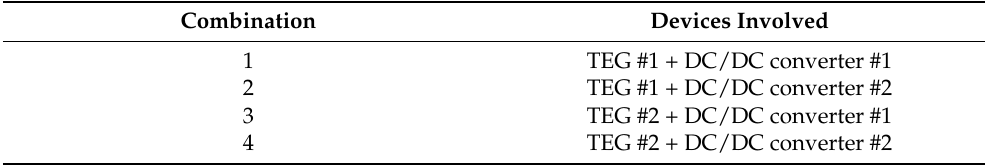
Table 1. Combinations of TEGs and DC/DC converters.